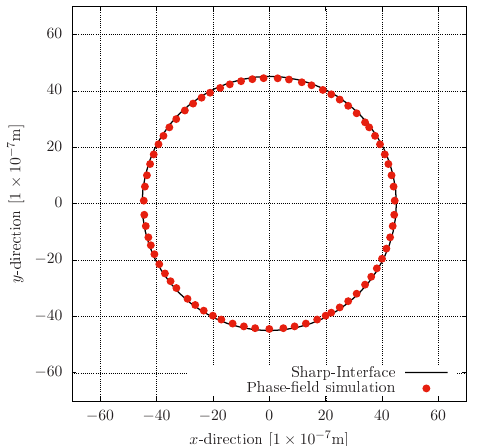
Figure 10. For a weak anisotropic solid–liquid interface, δ αβ = 0.005, a direct comparison with the sharp-interface equilibrium shape shows excellent agreement, and the obtained effective anisotropy = 0.0045 shows a minute variation when compared with the imposed δ e αβ